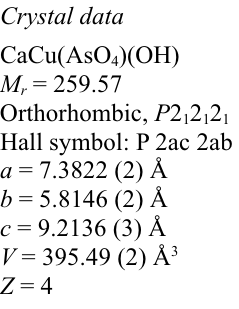
The crystal structure of conichalcite. Green octahedra, yellow tetrahedra, grey large sphares, and red small spheres ], [AsO ], Ca, and H, respectively. Hydrogen bonding is indicated with blue lines. represent [CuO 6 4 calcium copper(II) arsenate(V) hydroxide Crystal